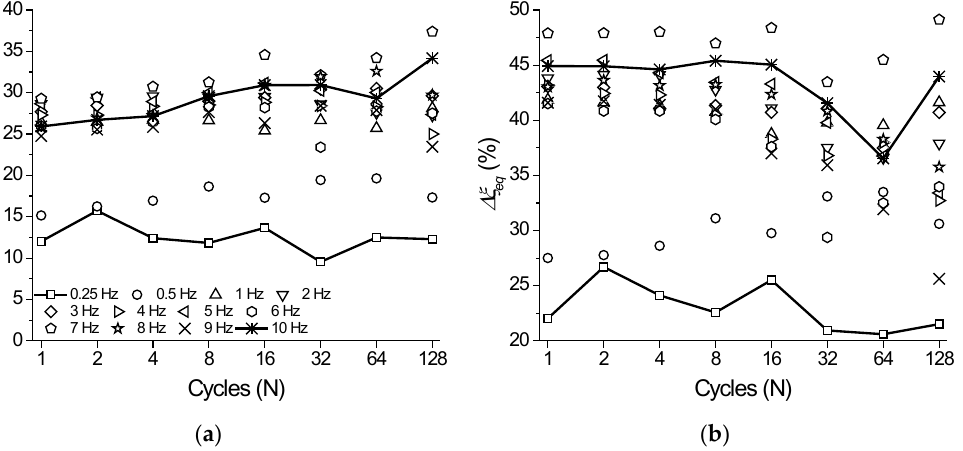
Figure 14. Percentage difference between the NiTi SMA micro cable and the reference element functional properties during cycling. ( a ) Dissipated energy. ( b ) Equivalent viscous damping factor.